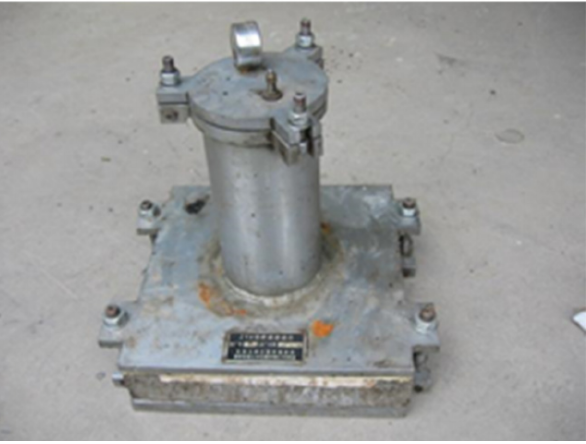
Figure 5. ZHY permeability